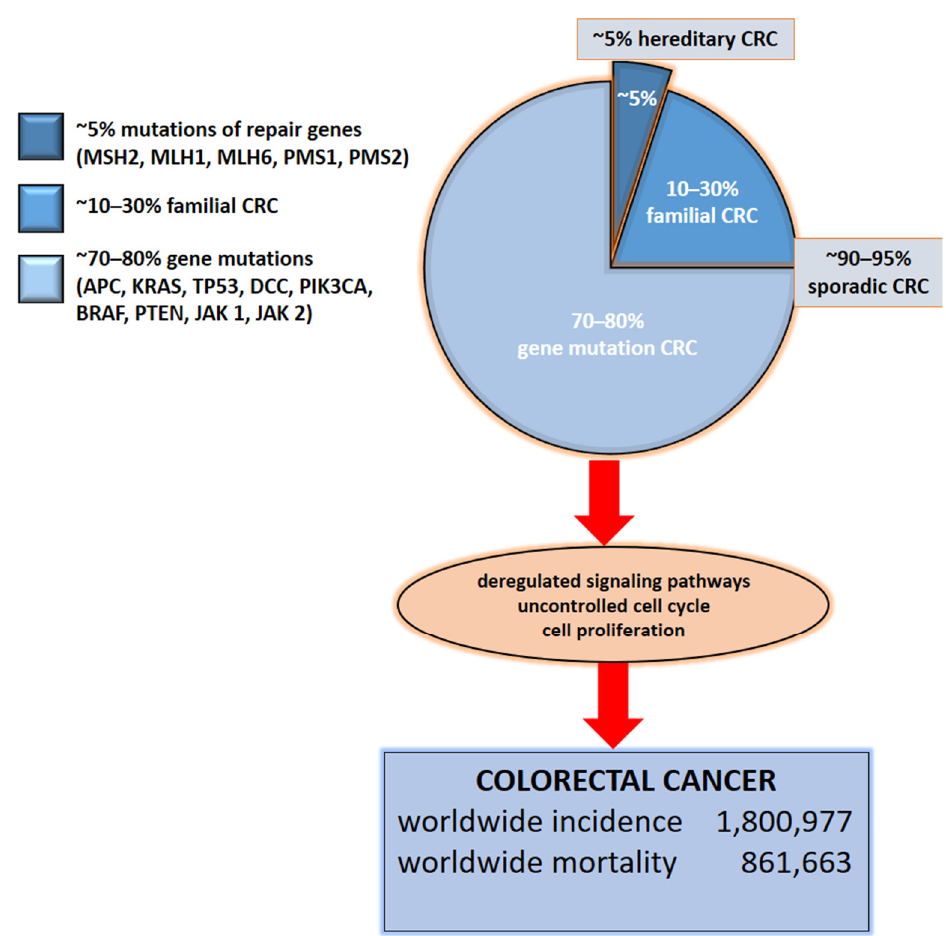
Figure 1. Molecular basis of CRC. Colorectal cancer is based on gene mutations, familial or hereditary CRC. The indication of total numbers refers to Global Cancer Statistics 2018 [3]. For worldwide incidence and mortality, colorectal cancer cases from 185 countries in 2018 were totaled.